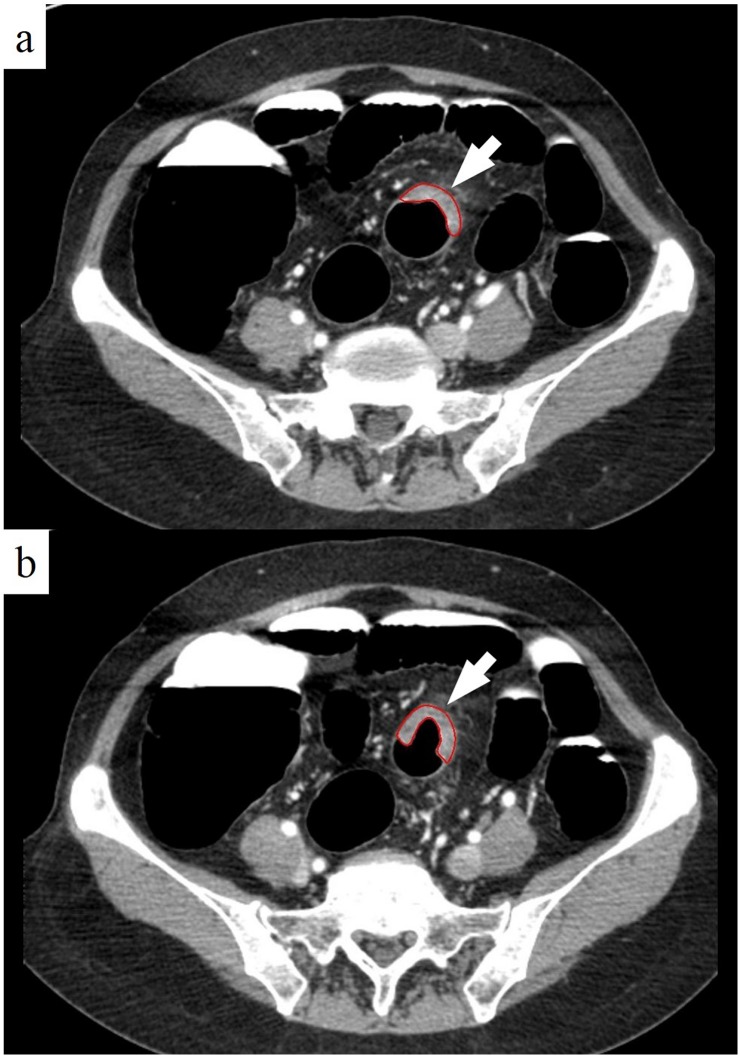
Volume measurement using CT colonography.a, b. Eccentric enhancing wall thickening (arrow) of the sigmoid colon is well demonstrated on axial CT images in prone position. Regions of interest (ROIs) (red line) are drawn covering abnormal wall thickening on every contiguous CT slices. Volume (cm3) is calculated by multiplying areas (cm2) and reconstruction interval (cm).